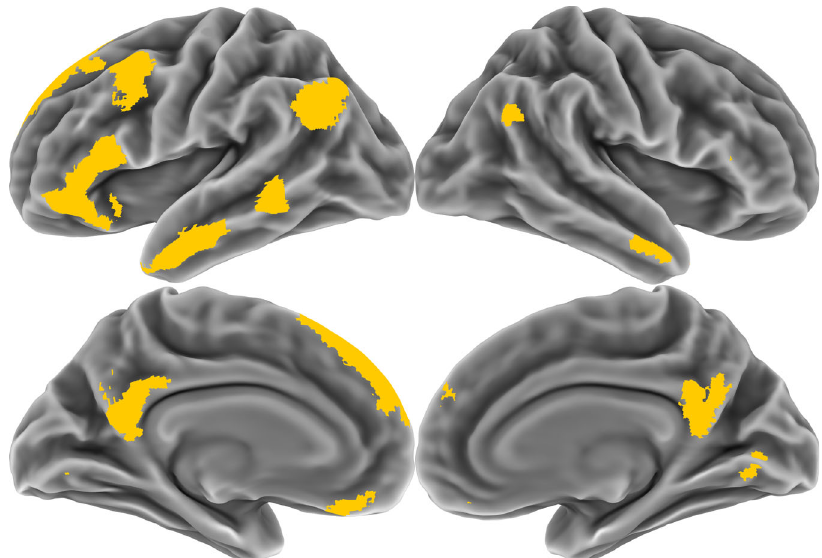
Fig. 5 The social brain network. All fMRI analyses were conducted using patterns drawn from within the yellow regions. These voxels were selected based on the voxelwise reliability threshold which maximized the patternwise reliability of the retained voxels with respect to the target people in the Person 2. Weight state patterns by frequency: Ratings of how often each target person experienced each state were averaged across participants in the two online rating samples. This produced two rating matrices: one 60 target by 15 state matrix and one 60 target by 45 state matrix. The former of these matrices was